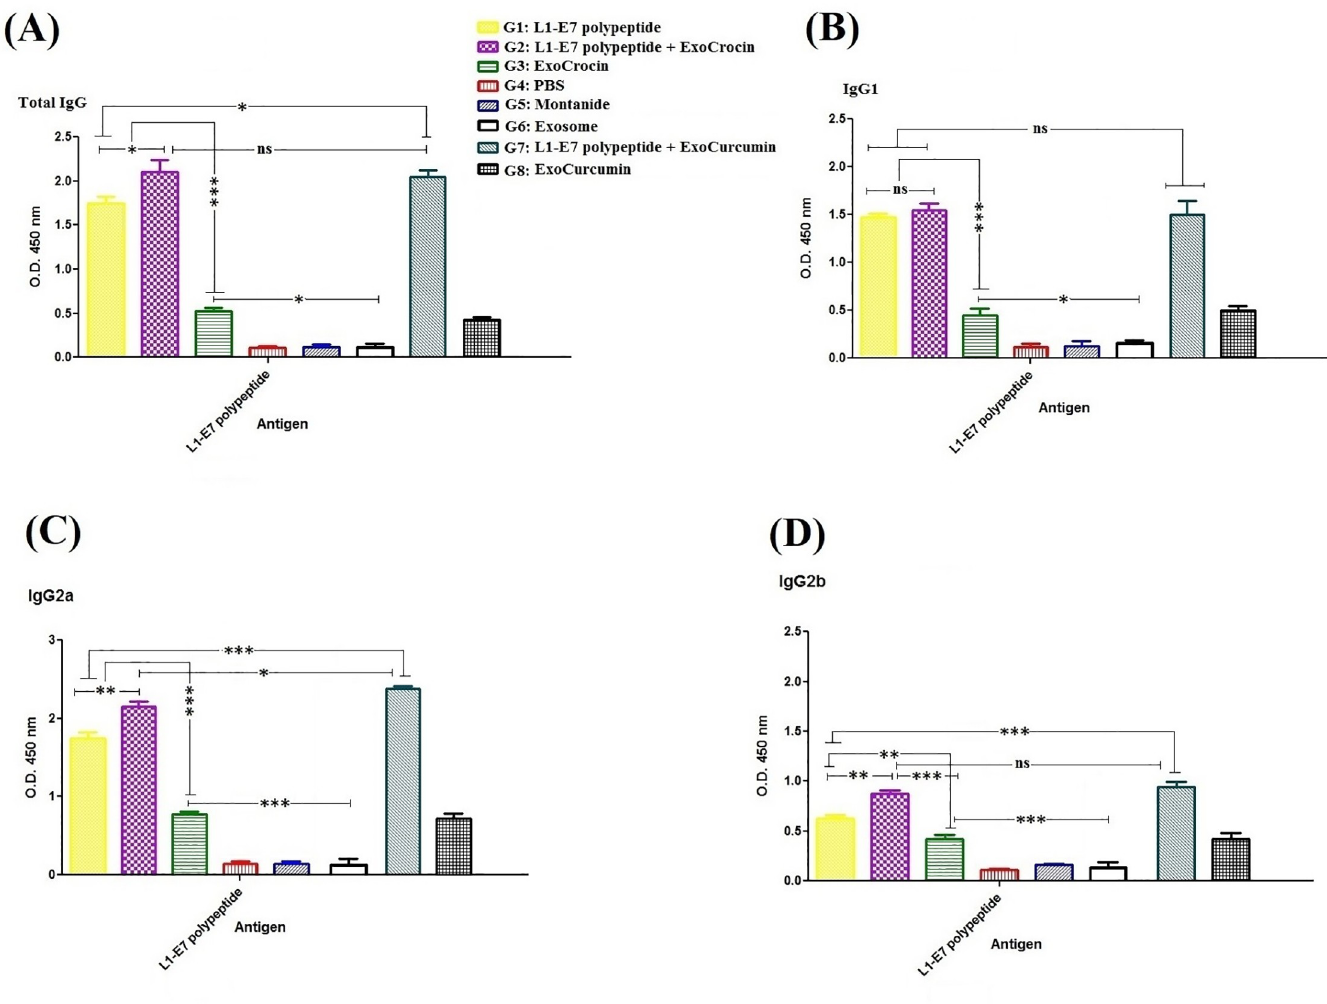
Fig 5. Evaluation of total IgG (A), IgG1 (B), IgG2a (C) and IgG2b (D) antibody responses in each group using indirect ELISA: All analyses were performed in duplicate for each sample. The results were shown as mean absorbance at 450 nm ± SD. ns: non-significant; � p < 0.05; �� p < 0.01; ��� p <